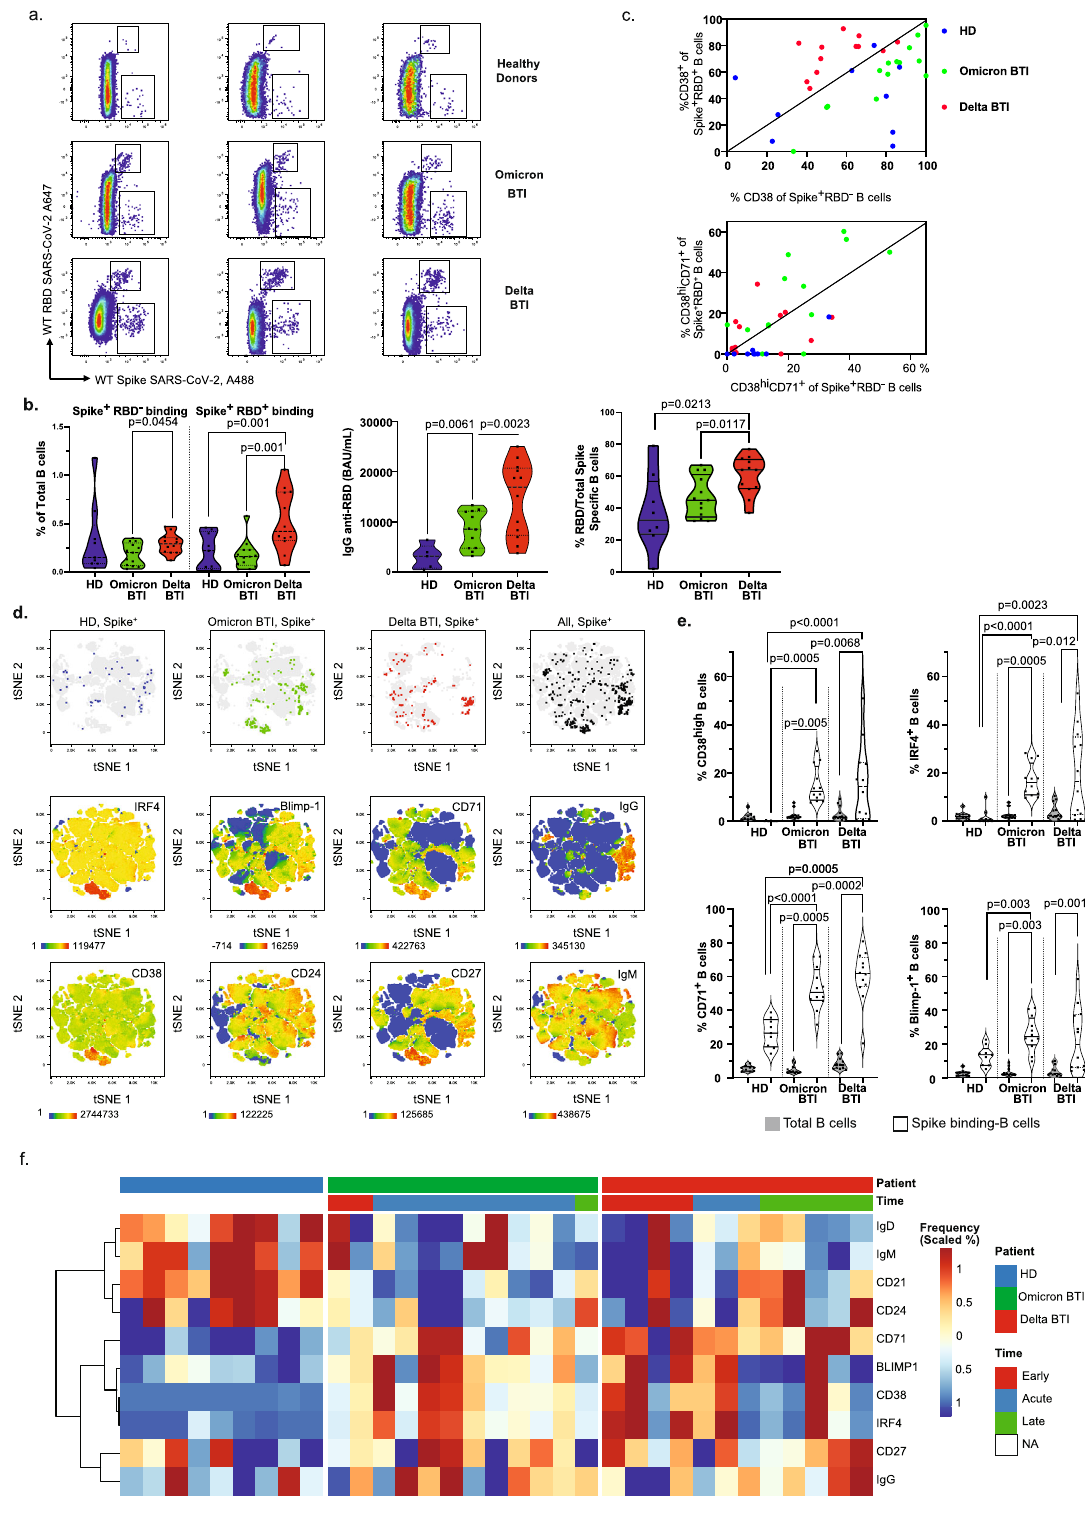
Omicron RBD 4,5,8,12 in vaccine-generated RBD-binding B cells and the requirement for af fi nity maturation or de novo responses to generate neutralizing antibodies. Nevertheless, we found that plasmablasts in Omicron BTI had a more balanced Spike + RBD + / Spike + RBD - ratio, suggesting the development of a new ser- ological RBD-response. This was supported by signi fi cantly increased IgG anti-RBD levels in Omicron BTI. In line with this, a